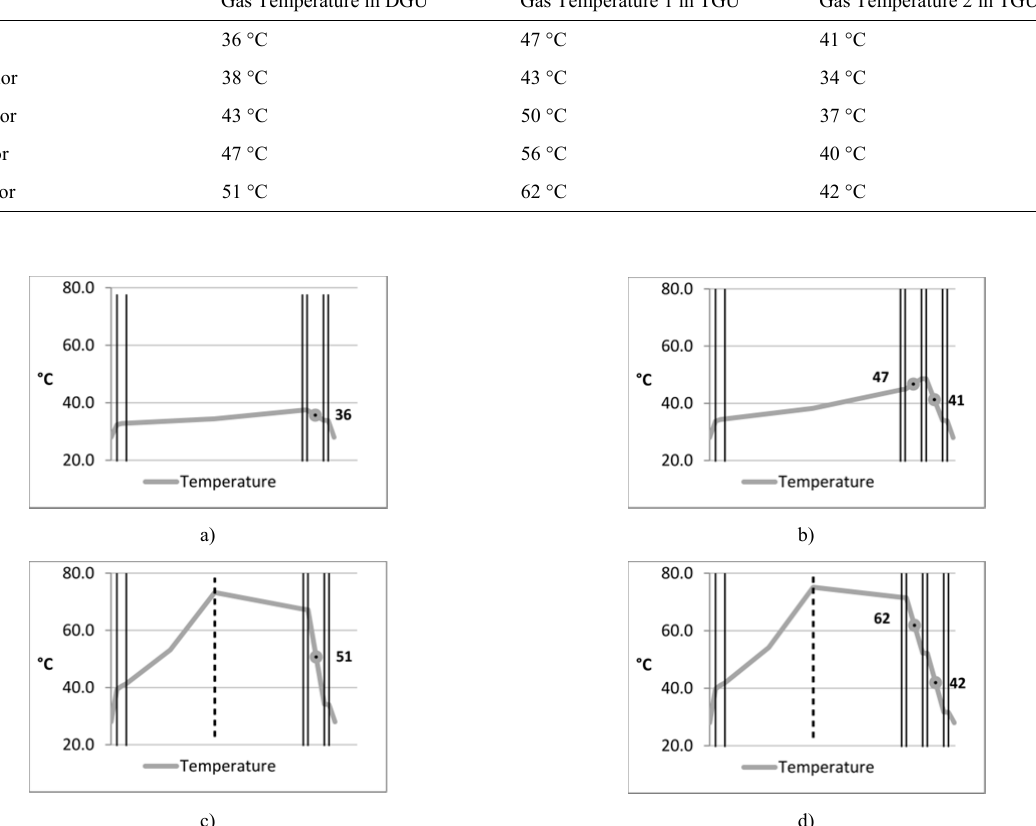
Fig. 6 Natural ventilated DSF with a) DGU, b) TGU, c) DGU with black sunblind and d) TGU with black